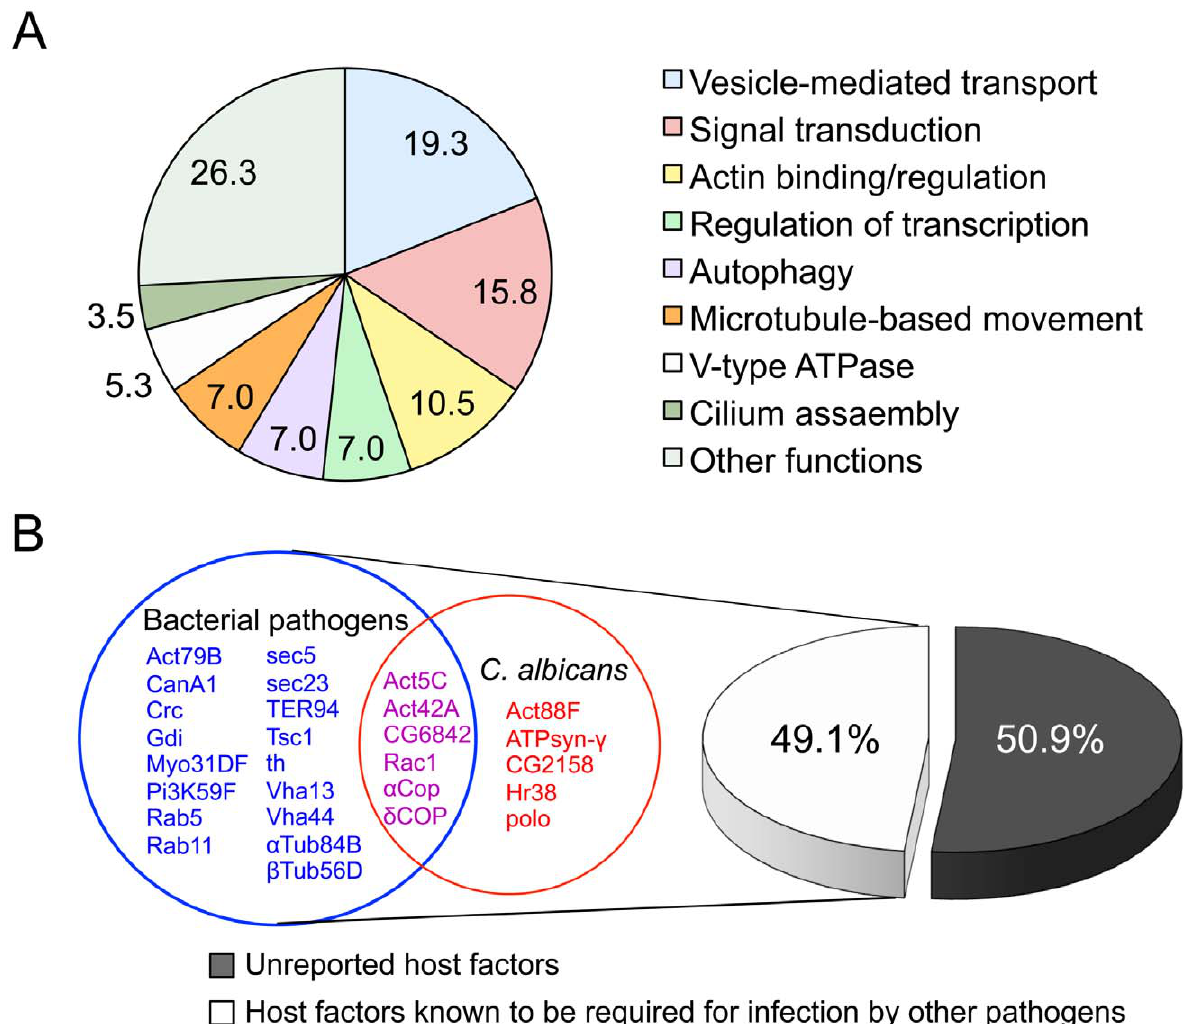
Figure 6. Identification of host factors regulating Cryptococcusneoformans infection. A . Fifty-seven host factors that, when depleted, significantly altered Cn infection phenotypes were identified in an RNAi screen using Drosophila S2 host cells. The 57 host factors were analyzed using established gene ontology categories (http://flybase.org/). The results were plotted in a pie chart with the percentage of genes in each category indicated. B . Comparison of the 57 identified host factors with those that were reported to mediate bacterial or fungal pathogen infection of host cells. Among the 57 hits, twenty-nine (50.9%) had not been previously reported to function as host factors for intracellular fungal pathogens. Shared and unique host factors were determined by analyzing published data from screens performed in S2 cells infected with the following pathogens: Brucella melitensis [41], Chlamydia caviae [43], Chlamydia trachomatis [44], Listeria monocytogenes [38,40], Mycobacterium fortuitum [40,42] and Candida albicans [39]. The host factors that are shared with other human pathogens (49.1%) are listed in red ( C. albicans ), magenta ( C. albicans and bacterial pathogens) and blue (bacterial pathogens). Each host factor mediates Cn phagocytosis and/or intracellular replication.